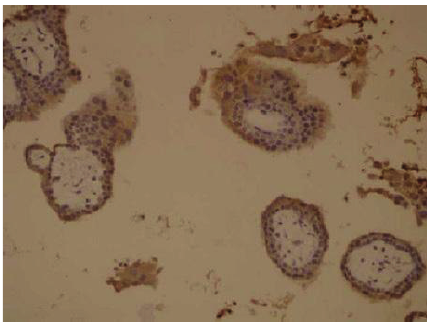
Figure 2: Weak glycodelin expression ( × 20).